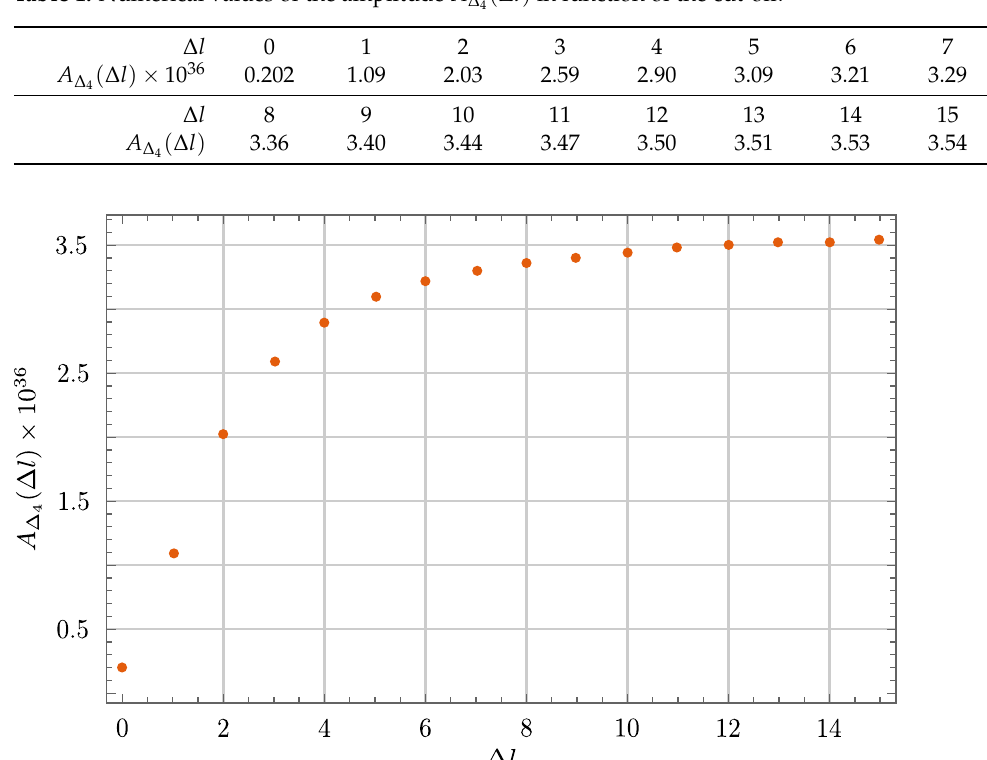
Table 1. Numerical values of the amplitude A ∆